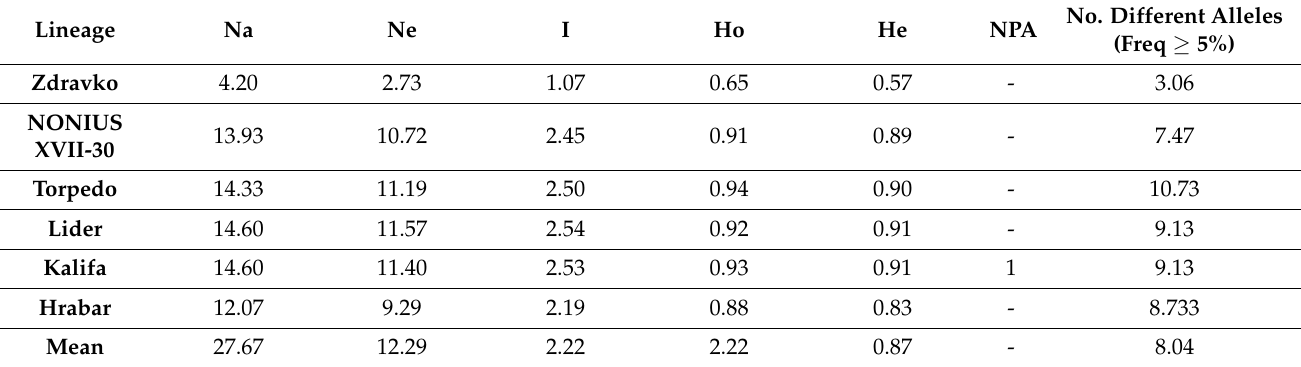
Table 4. Number of different alleles (Na), number of effective alleles (Ne), Shannon’s information index (I), observed (Ho) and expected (He) heterozygosity, number of private alleles unique to a single population (NPA), and Na freq. ≥ 5% (mean number of alleles for which the frequency is equal to or lower than 5%) in six paternal lineages of Danubian